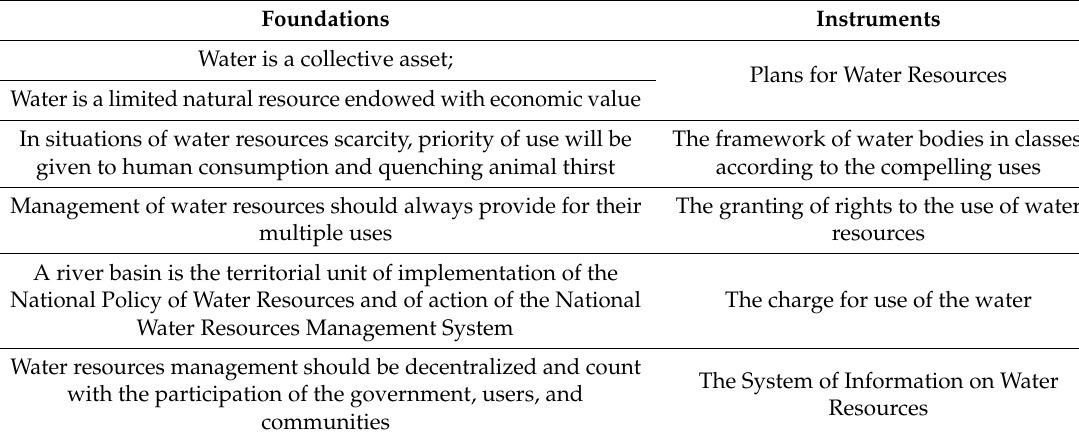
Table 1. Foundations and management instruments of Water Law No.